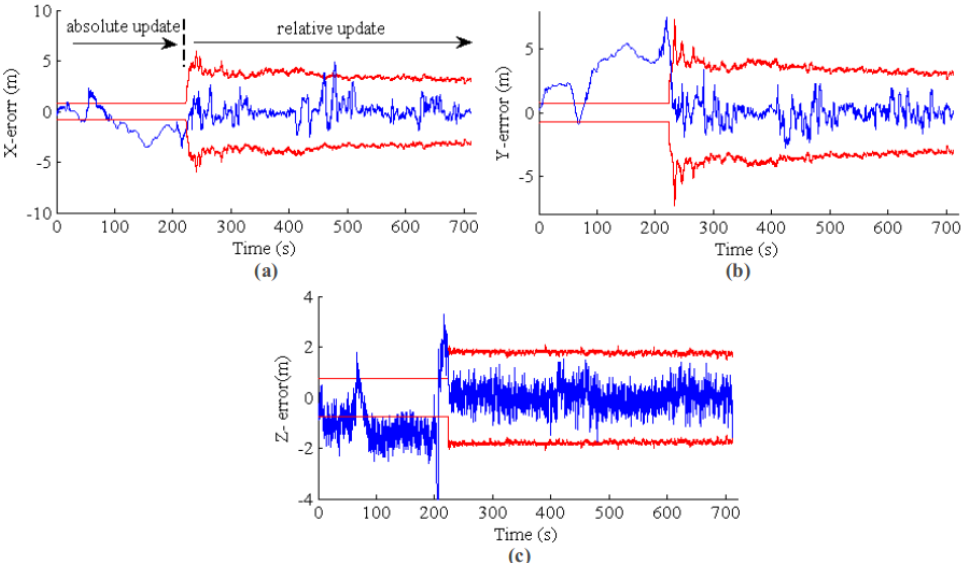
Figure 16. EKF state estimation error and consistency. ( a – c ) The results for X , Y and Z , respectively. The blue line is the position error, and the red line is the 3 σ error band from the state covariance. Because VO absolute measurement is fused in the initial phase, the state estimation is overconfident and inconsistent. Furthermore, the GPS and barometric measurements are prohibited from updating the EKF state. After the VO is switched to the relative measurement model, the EKF state becomes consistent, and the error is bounded in the 3 σ